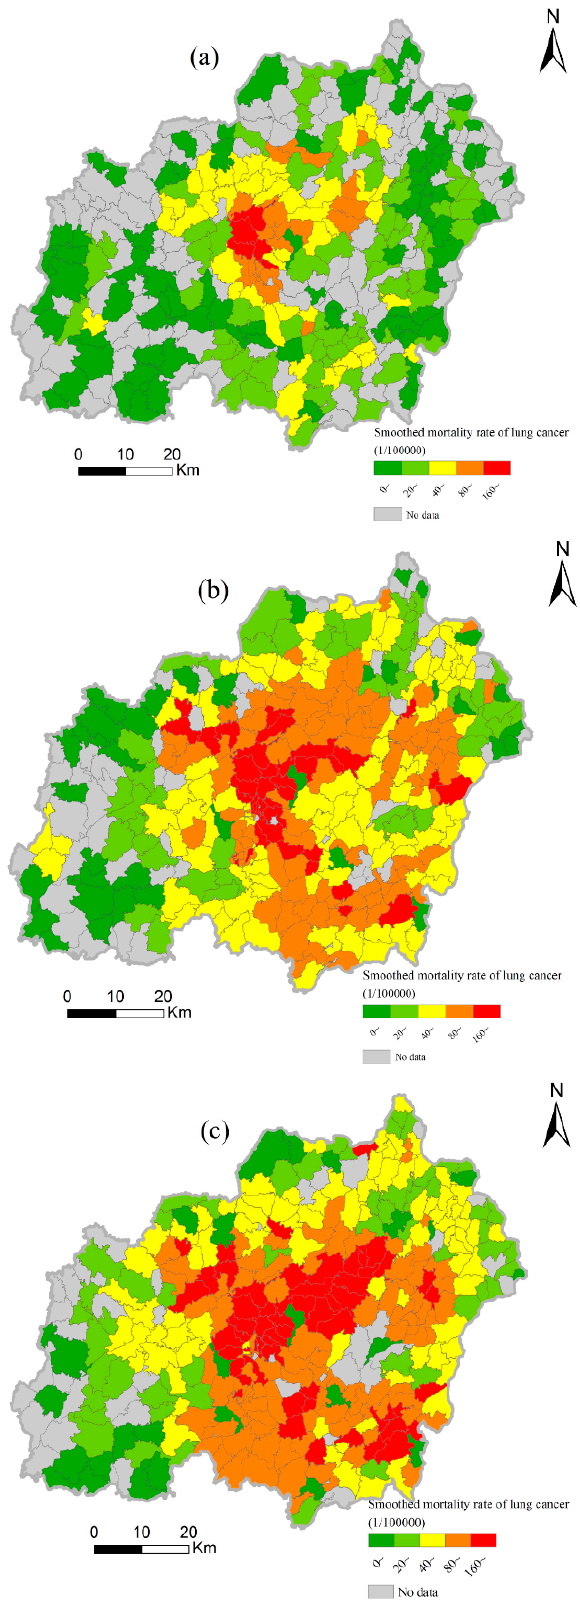
7 Figure 4. Spatial disparities of the village-level mortality rate of lung cancer during 1990–1992 ( a );